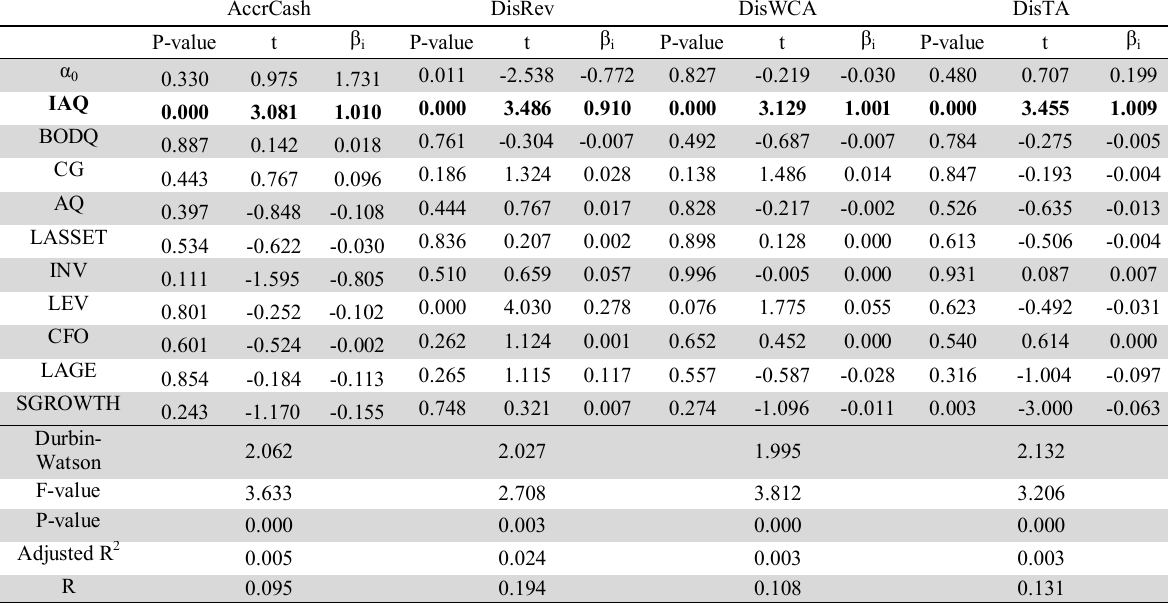
The summary of regression